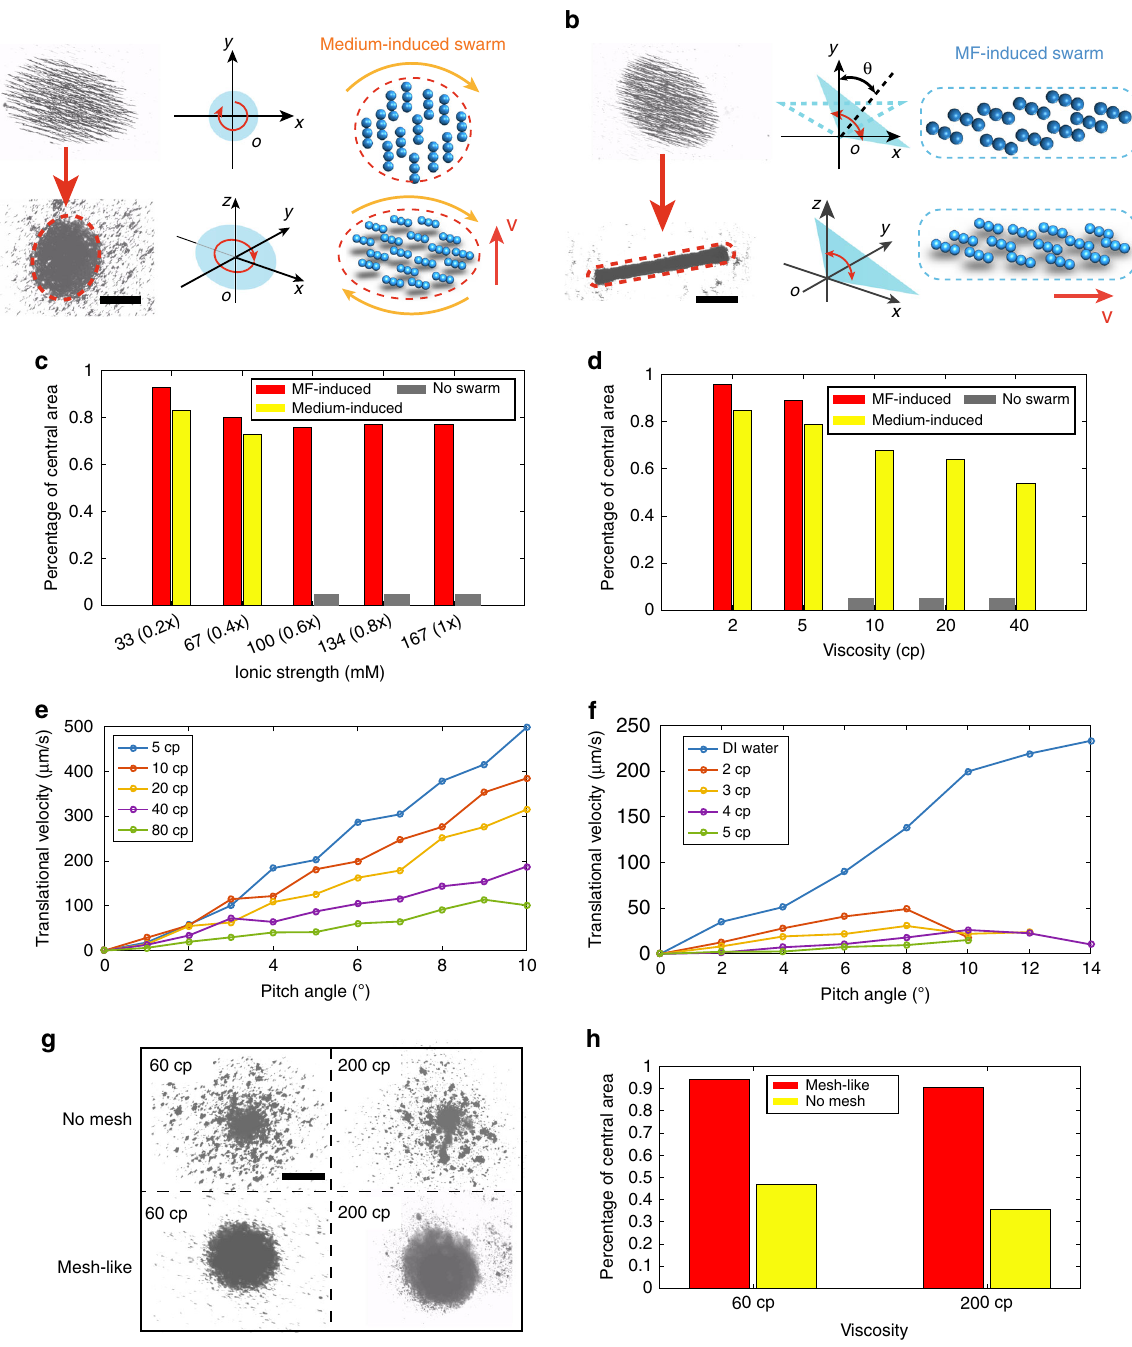
Fig. 2 Generation and locomotion of the swarms in ionic and viscous fl uids. a Schematics and an experimental image of the medium-induced swarms. The actuation fi elds are indicated by the blue planes. b Schematics and an experimental image of the MF-induced swarms. Oscillating magnetic fi elds are used to trigger the swarm behaviour, and the fi elds are shown by the blue planes. When the direction of the oscillating fi eld changes, the angle between the centre line and y -axis is labelled using θ . The red dashed ellipses indicate the central areas of the swarms. c , d The percentages of the central areas of the swarms in fl uid with different ionic strengths and viscosities, respectively. The ionic strengths of the fl uids are normalised using PBS solution, and the ionic strength in PBS solution is 1.0 ´ . e , f The translational velocities of the medium-induced and MF-induced swarms in fl uids with different viscosities, respectively. g The experimental results of the medium-induced swarms generated in fl uids with and without mesh-like structures. The viscosities of the fl uids are kept the same, i.e. 60 and 200 cp, respectively. The shear rate is 5 s (cid:3) 1 . h The comparisons between the central percentages of the medium- induced swarms generated in fl uids with and without mesh-like structures. The scale bars indicate 500 μ